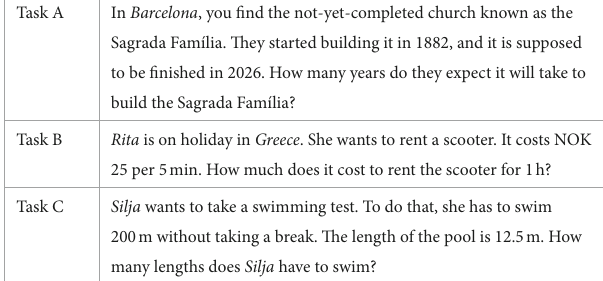
TABLE 1 The three selected tasks (authors’